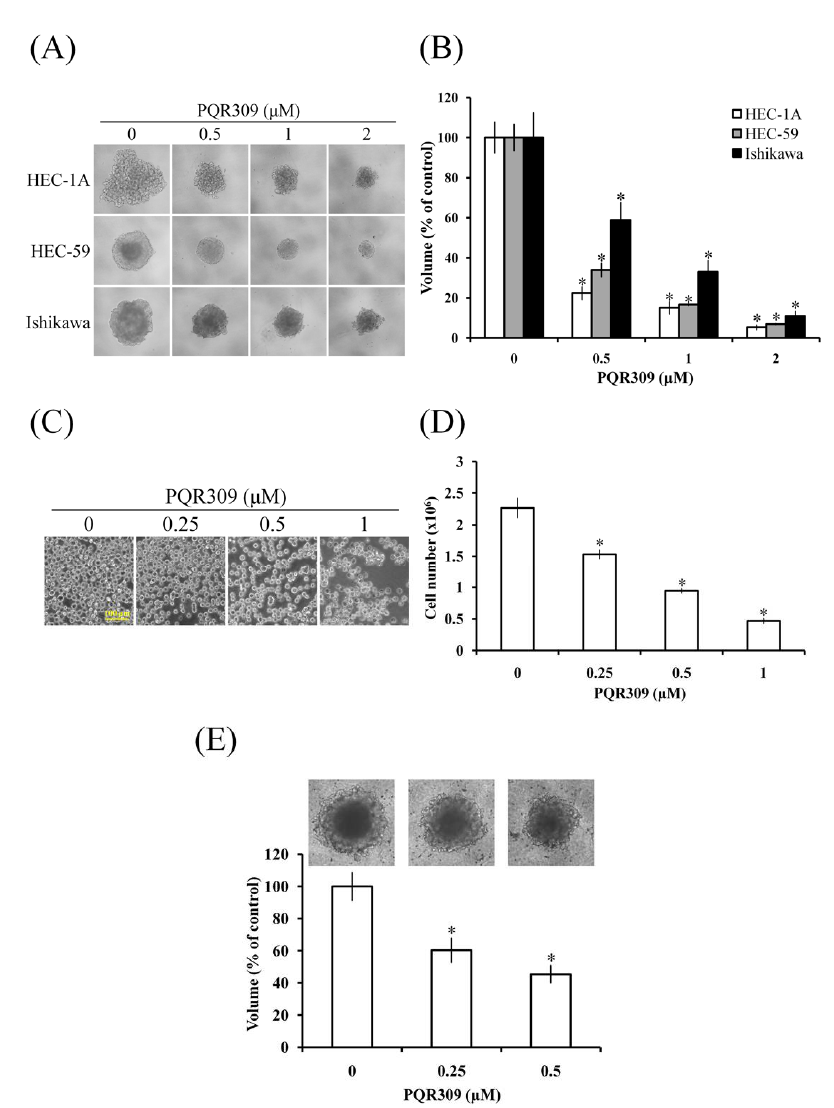
Figure 2. Effect of PQR309 on tumor spheroid formation in endometrial cancer cells. ( A ) HEC-1A, HEC-59, and Ishikawa cells (1 × 10 3 cells/well of 96-well dish) were seeded onto ultra-low-attachment 96-well plates. After 96 h incubation, PQR309 (0, 0.5, 1, and 2 μM)-containing medium was added to the well, and the spheroids were incubated for 7 days. Spheroids were investigated under an inverted microscope. ( B ) The volumes of spheroids were determined by the formula 0.5 × larger diameter × small diameter 2 . Data show the relative spheroid volume, and the volume of spheroid without PQR309 treatment was set at 100%. ( C ) AN3CA-S cells (6 × 10 5 cells/well of 6-well dish) were seeded onto ultra-low-attachment 6-well plates. Scale bar indicates 100 μm. ( D ) Cell number of Figure 2C was counted under an inverted microscope. ( E ) HEC-59 cells (1 × 10 3 cells/well of 96-well dish) were seeded onto ultra-low-attachment 96-well plates. After 96 h incubation, PQR309 (0, 0.25, and 0.5 μM)-containing medium with 25% Matrigel was added to the well, and the spheroids were incubated for 7 days. Spheroids were investigated under an inverted microscope. The volumes of spheroids of Figure 2A were determined by the formula 0.5 × larger diameter × small diameter 2 . Data show the relative spheroid volume, and the volume of spheroid without PQR309 treatment was set at 100%. The symbol ∗ indicates p < 0.05.